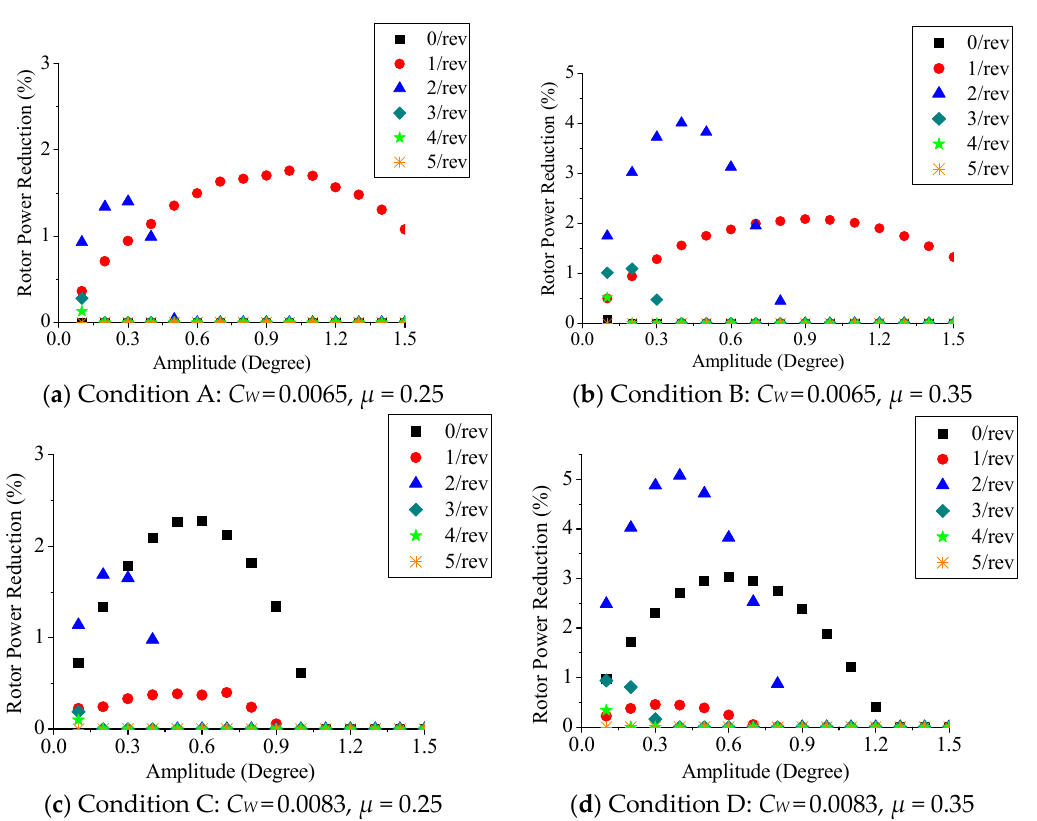
Figure 10. Rotor power reduction of uniform twist control with the 0/rev and single-harmonic inputs.